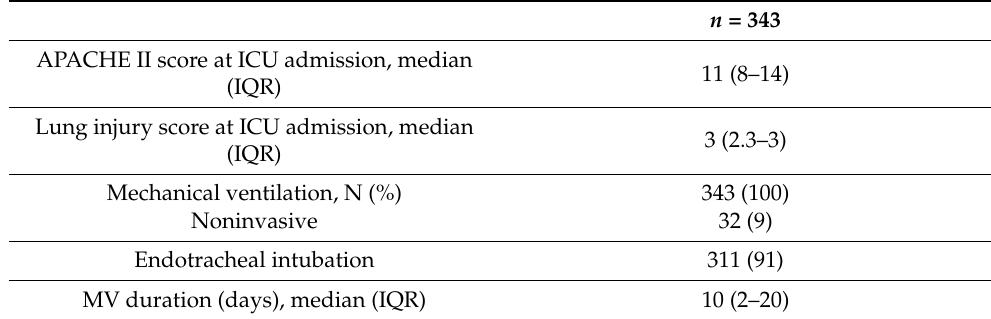
Table 2. Main hospital and ICU